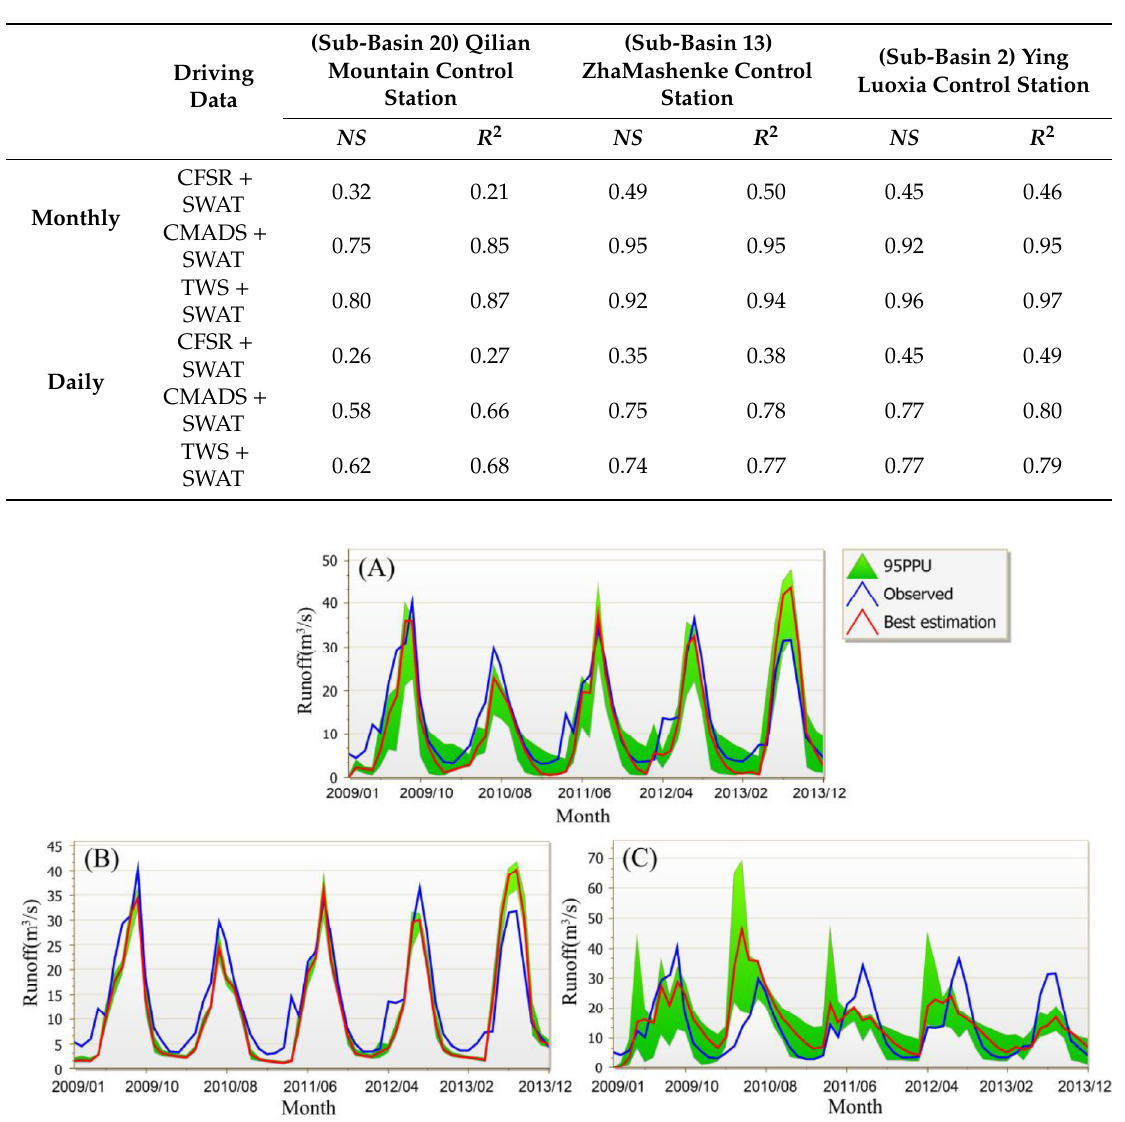
Figure 6. Simulation results of monthly average runoff by the three different modes at Qilian Mountain control station from 2009 to 2013: ( A ) CMADS + SWAT mode; ( B ) TWS + SWAT mode; ( C ) CFSR + SWAT mode.